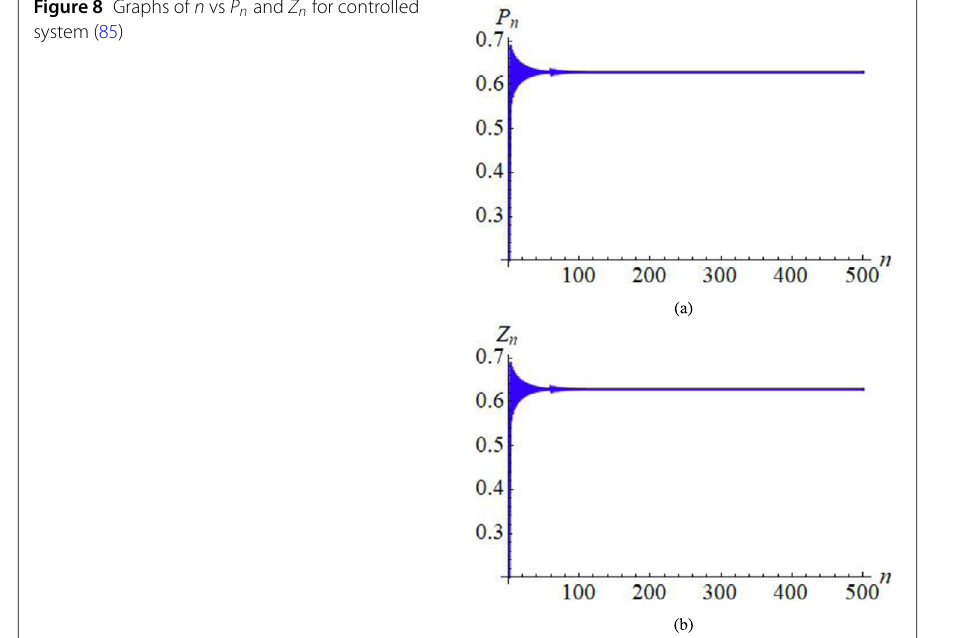
Figure 8 Graphs of n vs P n and Z n for controlled system